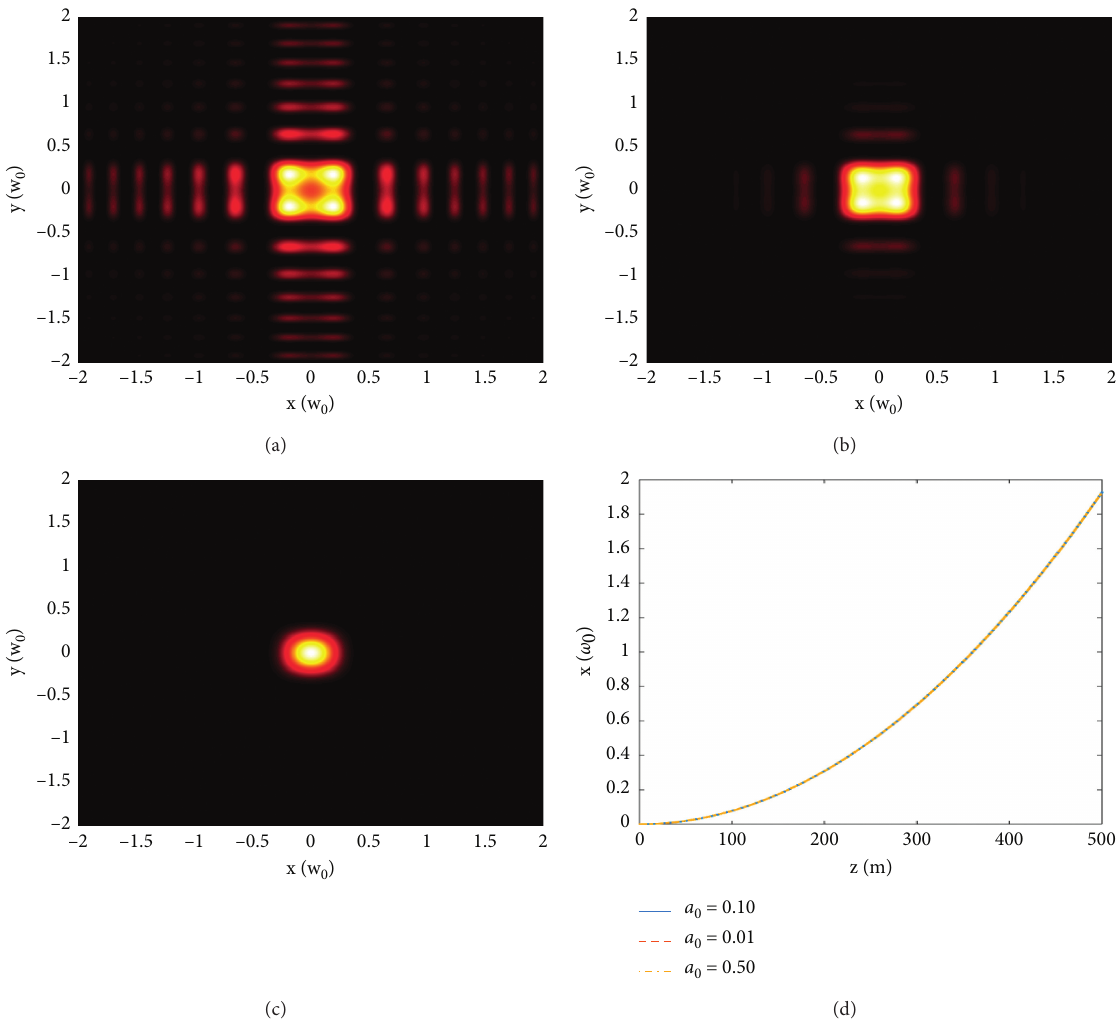
� 1.55um, σ � 100mm, ω � 0.2m, and 0